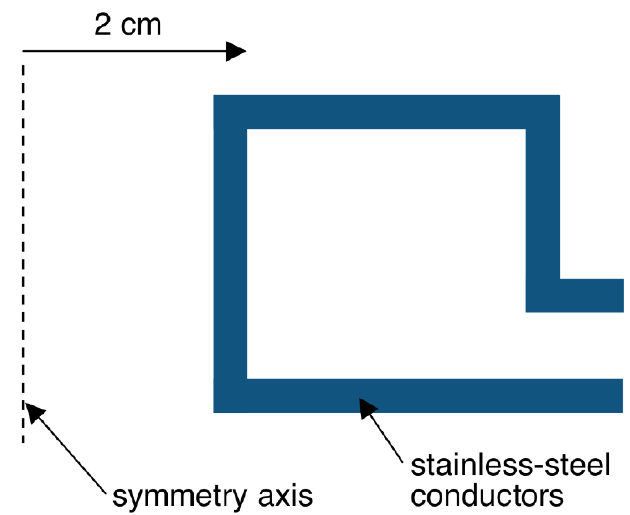
FIG. 4. (Color) Cross-sectional view of the system of stainless- steel conductors fielded as the load on Z-accelerator-shot 533. The illustration is to scale. The conductors are 0.3-cm thick; the outer radius of the conductors is 5.38 cm.